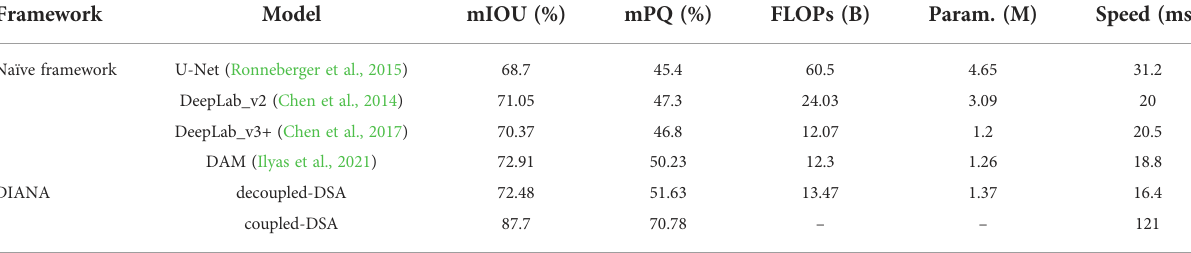
TABLE 6 Evaluation of performance on the DSA task of both frameworks.